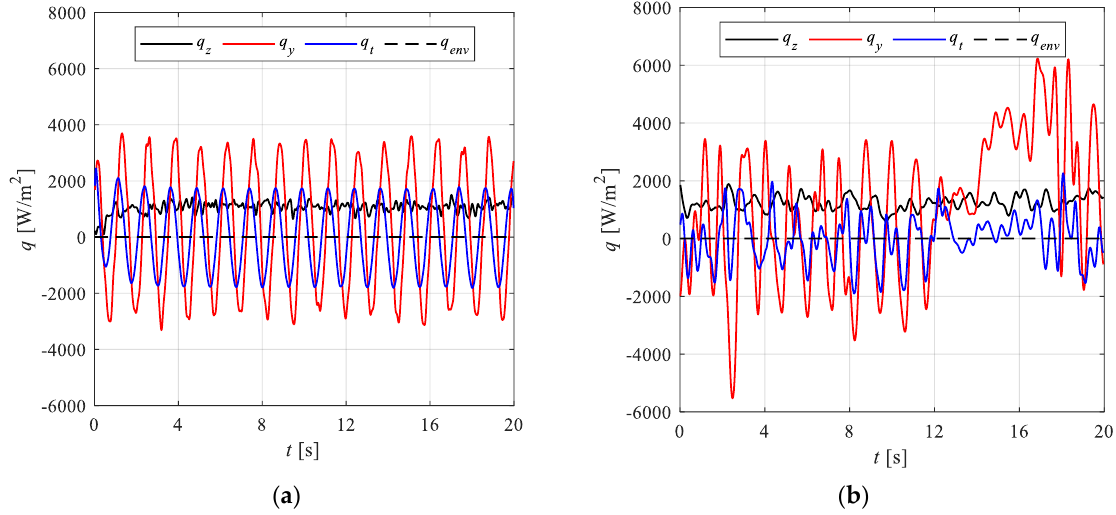
Figure 6. Comparison between numerical ( a ) and experimental ( b ) data for the validation of the assumption adopted in Equation